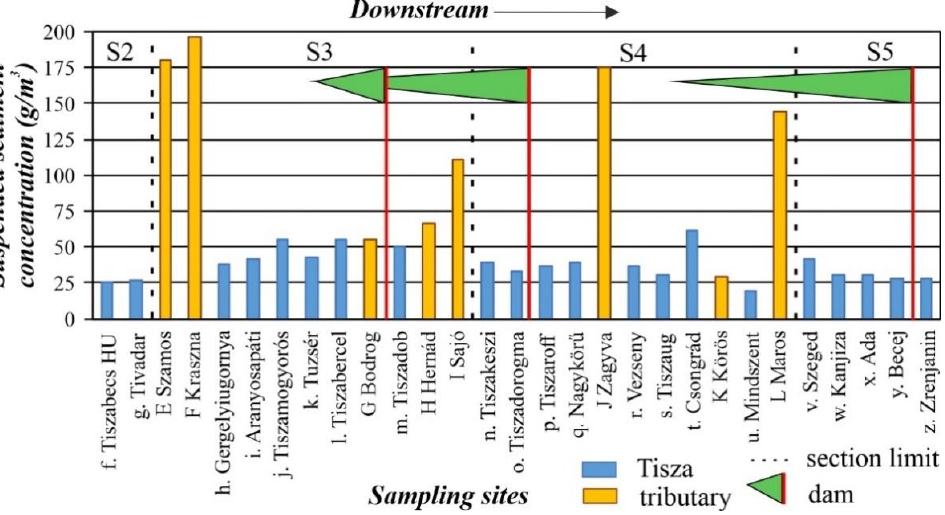
Figure 3. Longitudinal changes in suspended sediment concentrations (SSC) along the Tisza and its tributaries in 2022. The S2 – S5 indicate the hydro-morphologically uniform sections of the Tisza.